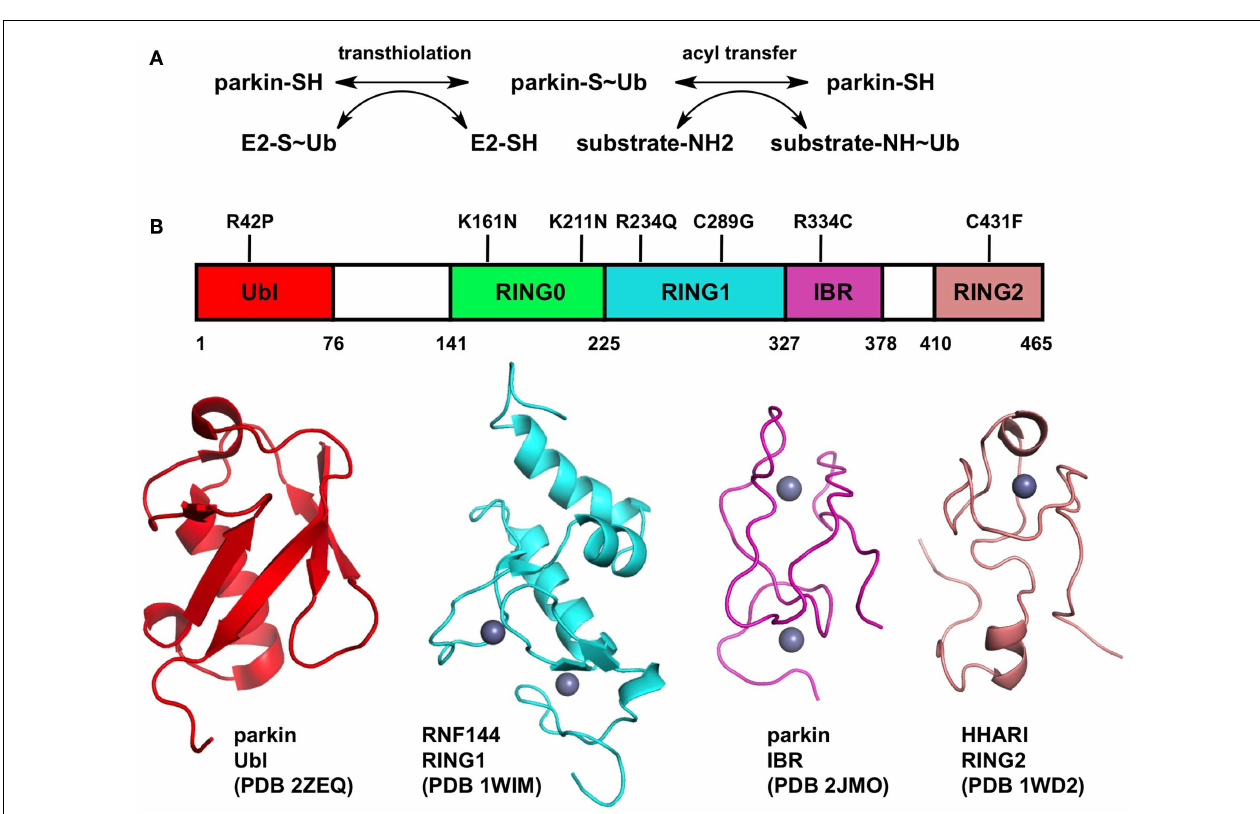
substrate amino group, typically a lysine side-chain. (B) Structure of Parkin. The domain boundaries of full-length human Parkin and selected PD mutations are displayed at the top.The structures of individual domains from Parkin or RBR homologs are shown below. Zinc atoms are displayed as gray